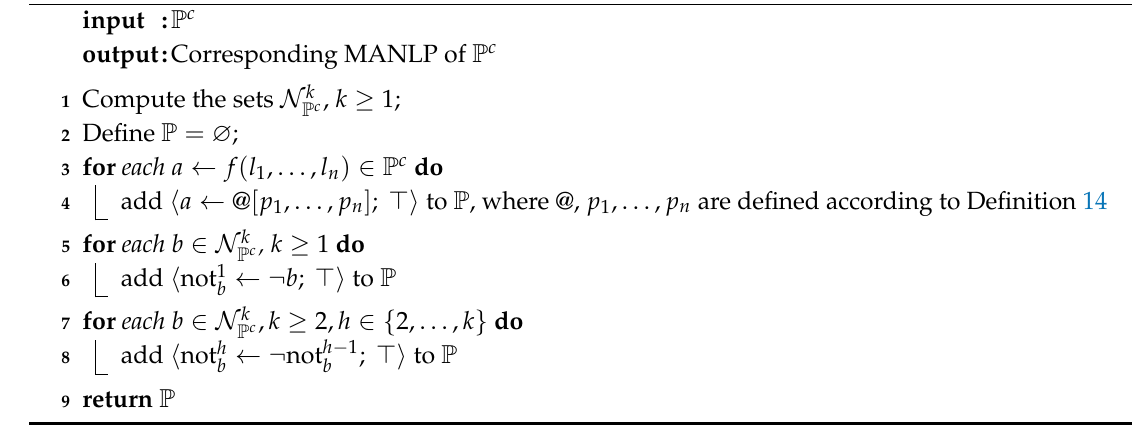
Algorithm 2: Corresponding MANLP of a